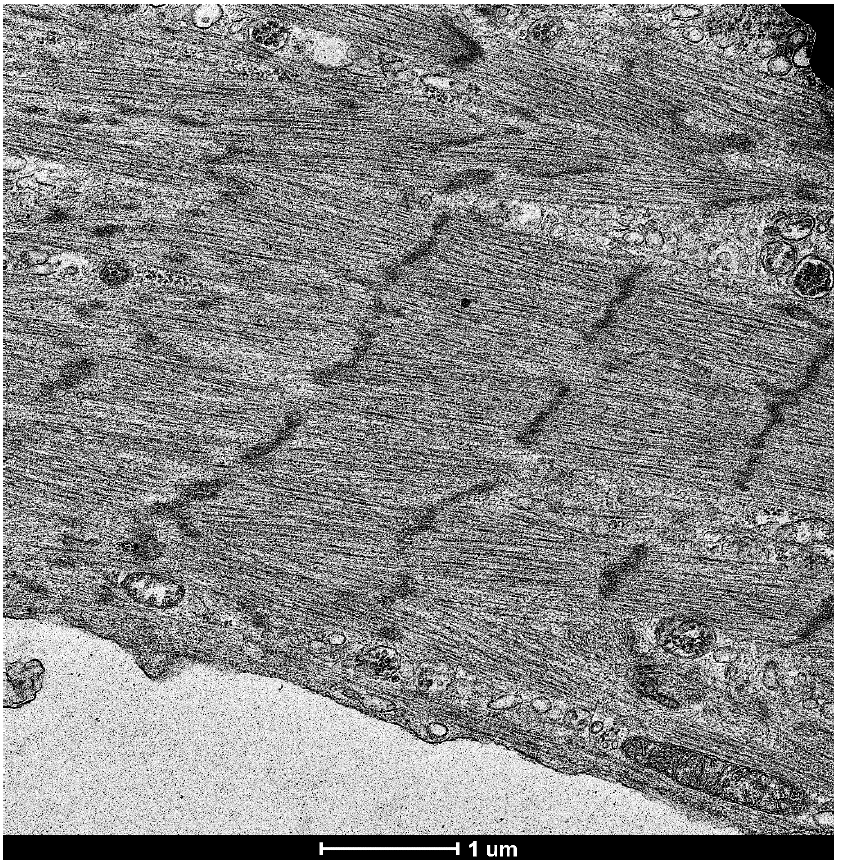
Figure 2. Transmission electron microscopy image of cardiomyocytes produced from fibroblast-derived iPSCs. The reprogramming technology was used to convert cultured human fibroblasts into iPSCs and then into cardiomyocytes (Cell Applications, Inc., San Diego, CA, USA). Cells were then fixed in the 2.5% glutaraldehyde/0.05 M cacodylate solution, post-fixed with 1% osmium tetroxide and embedded in EmBed812 (Electron Microscopy Sciences Hatfield, PA, USA). Ultrathin sections (70 nm) were post-stained with uranyl acetate and lead citrate and examined in the Talos F200X FEG transmission electron microscope (FEI, Hillsboro, OR, USA) [18]. The image shows the cells developed from fibroblasts having clear striations and sarcomere structures. Magnification 5500×.